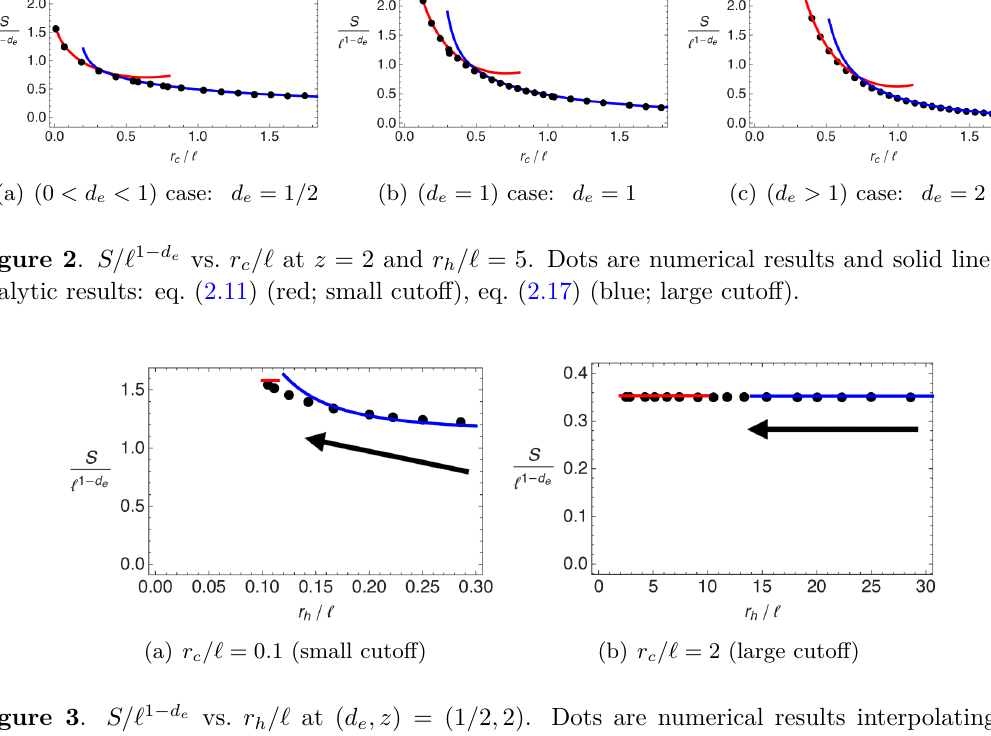
; left panel) or h → ∞